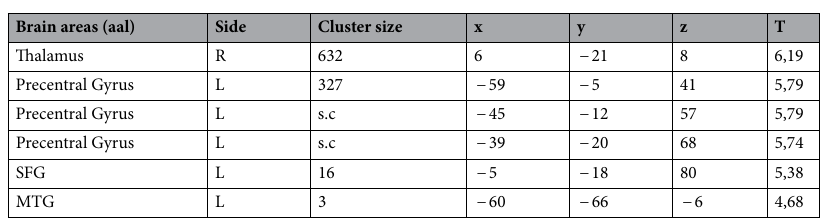
Table 3. Cluster list for contrast heterosexual males > homosexual males (threshold p < 0.05 FWE corrected at voxel level). L/R left/right in the brain; s.c. sub-cluster, SFG Superior Frontal Gyrus; MTG Middle Temporal Gyrus.